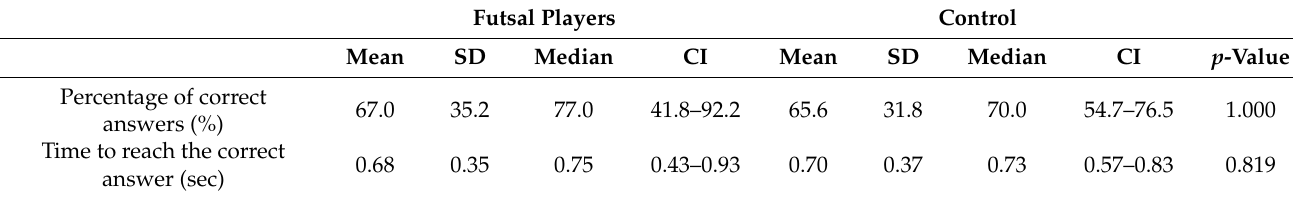
Table 2. Results of eye–hand coordination test.